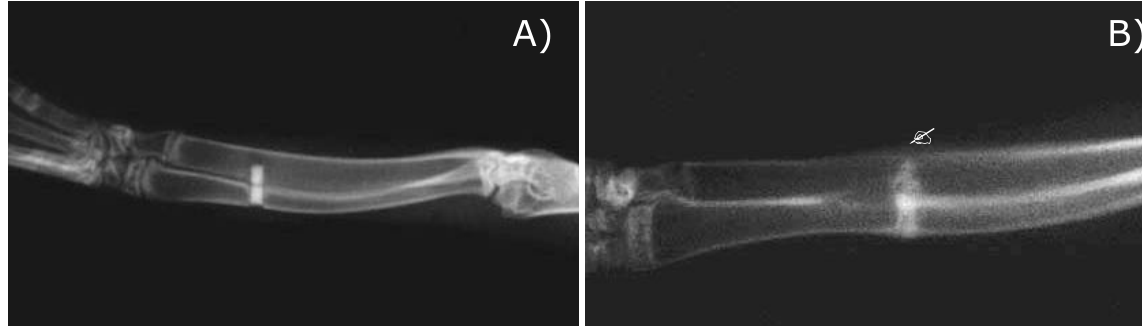
FIGURA 2 - Imagens ilustrando o aspecto radiográfico do cimento de fosfato de cálcio, no período pós-operatório imediato (A) e após 180 dias, com o processo de reabsorção avançado (B).